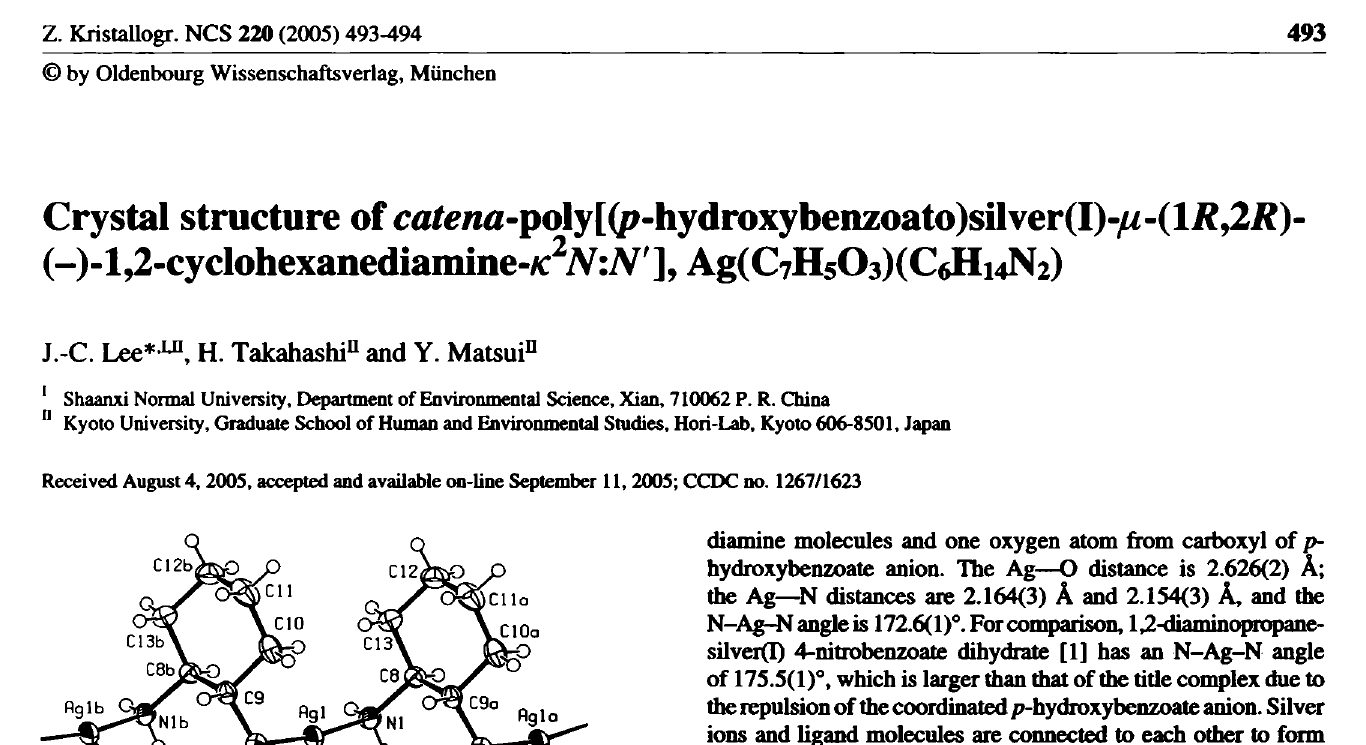
Table 2. Atomic coordinates and displacement parameters (in A 2